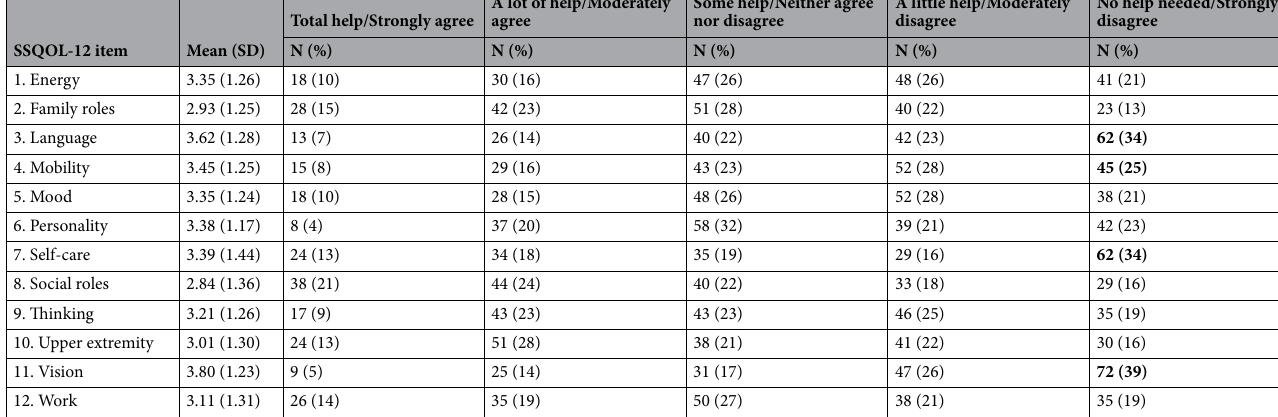
Table 2. Distribution of the scores of the 12 SSQOL items at baseline. N = 184. The ceiling effects for four SSQOL items are bolded. SSQOL = Stroke-Specific Quality of Life